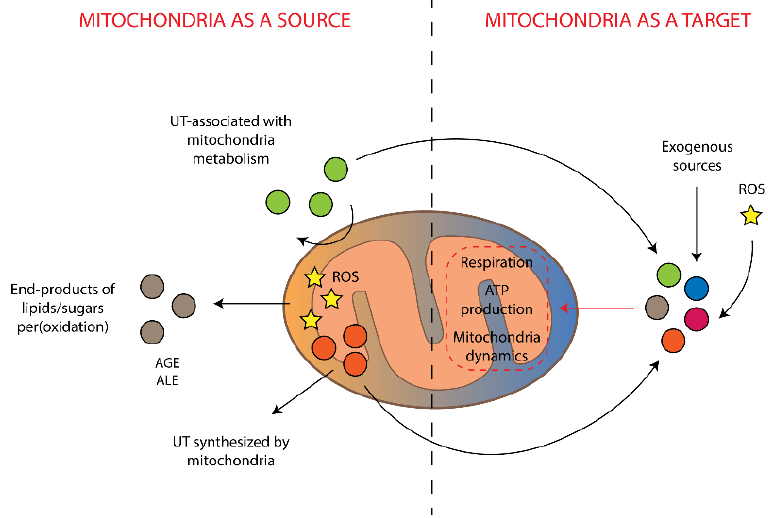
Figure 2. Interrelations between mitochondria-associated production of uremic toxins and damaging effects of the toxins on mitochondria. UT is uremic toxins, AGE is advanced glycation end-products, ALE is advanced lipoxidation end-products, ROS is reactive oxygen species.